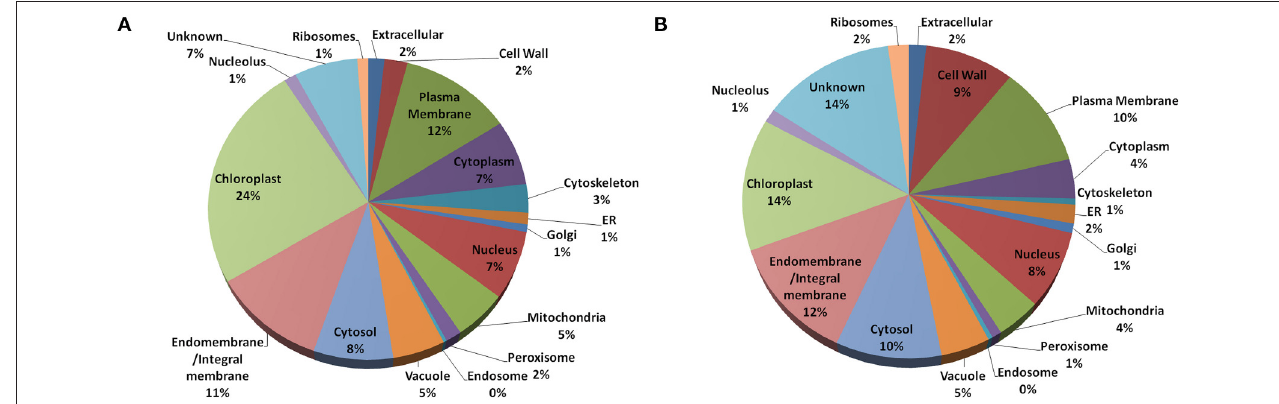
FIGURE 3 | The pie-chart of the predicted cellular localization obtained using the gene ontology annotation for old “prokaryotic” proteins in Arabidopsis (A) and Oryza sativa (B). In both, Arabidopsis and Oryza sativa , old prokaryotic proteins were predicted to be localized in the chloroplast and membranous regions.